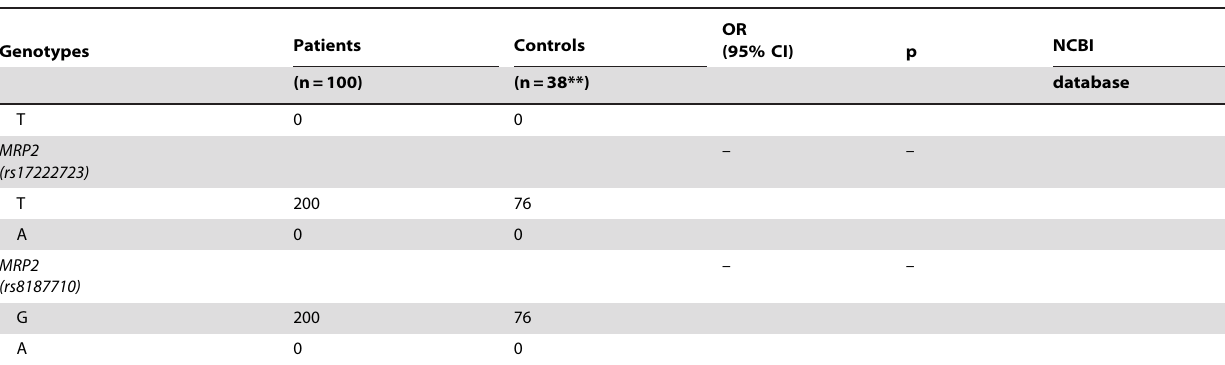
*statistically significant. **4 controls who were siblings of patients were excluded. a CC vs CT/TT. b TT vs AT/AA. c GG/AG vs